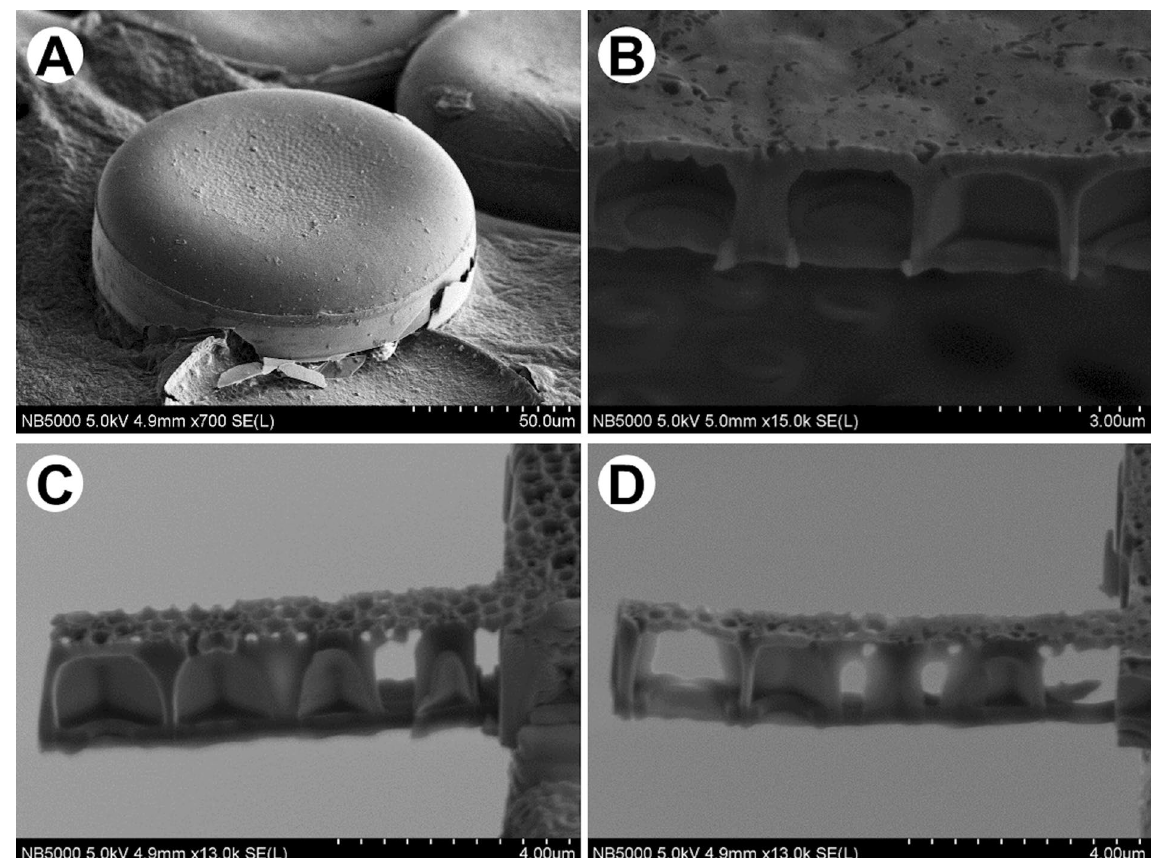
Figure 6. SEM images of Coscinodiscus sp.: ( A ) whole frustule; ( B ) cross-section of the shell; ( C–D ) samples prepared with ion beam for synchrotron